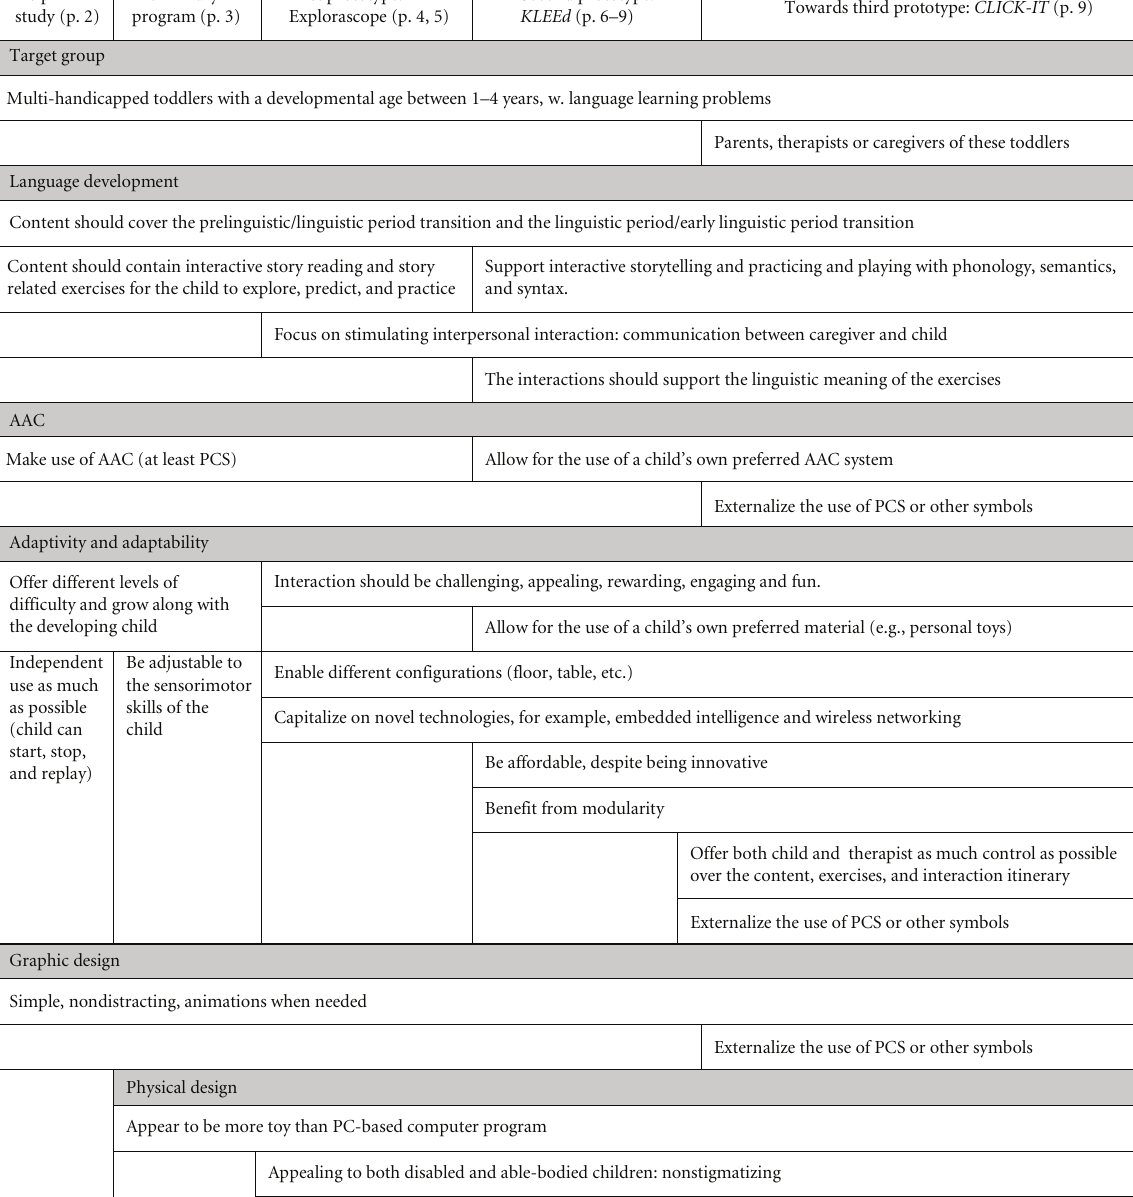
Table 1: Summary of guidelines for the LinguaBytes product (time passes from left to right, guidelines accumulate). Delphi study (p.